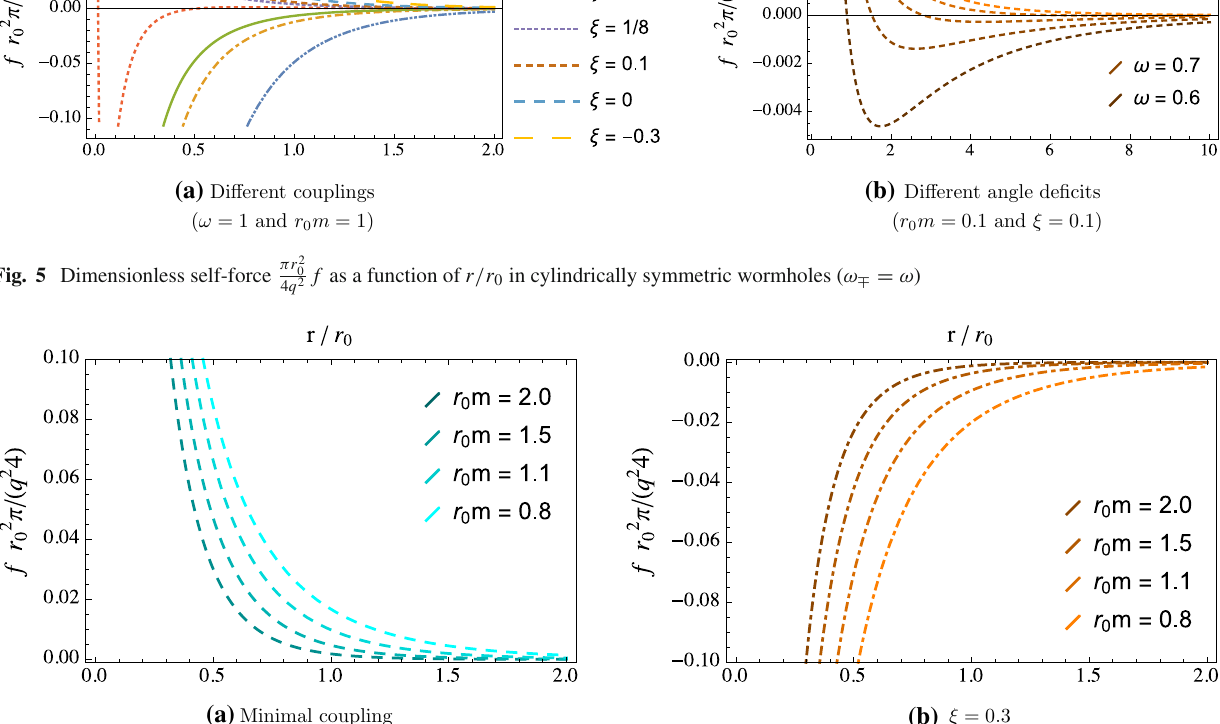
Fig. 6 Dimensionless self-force